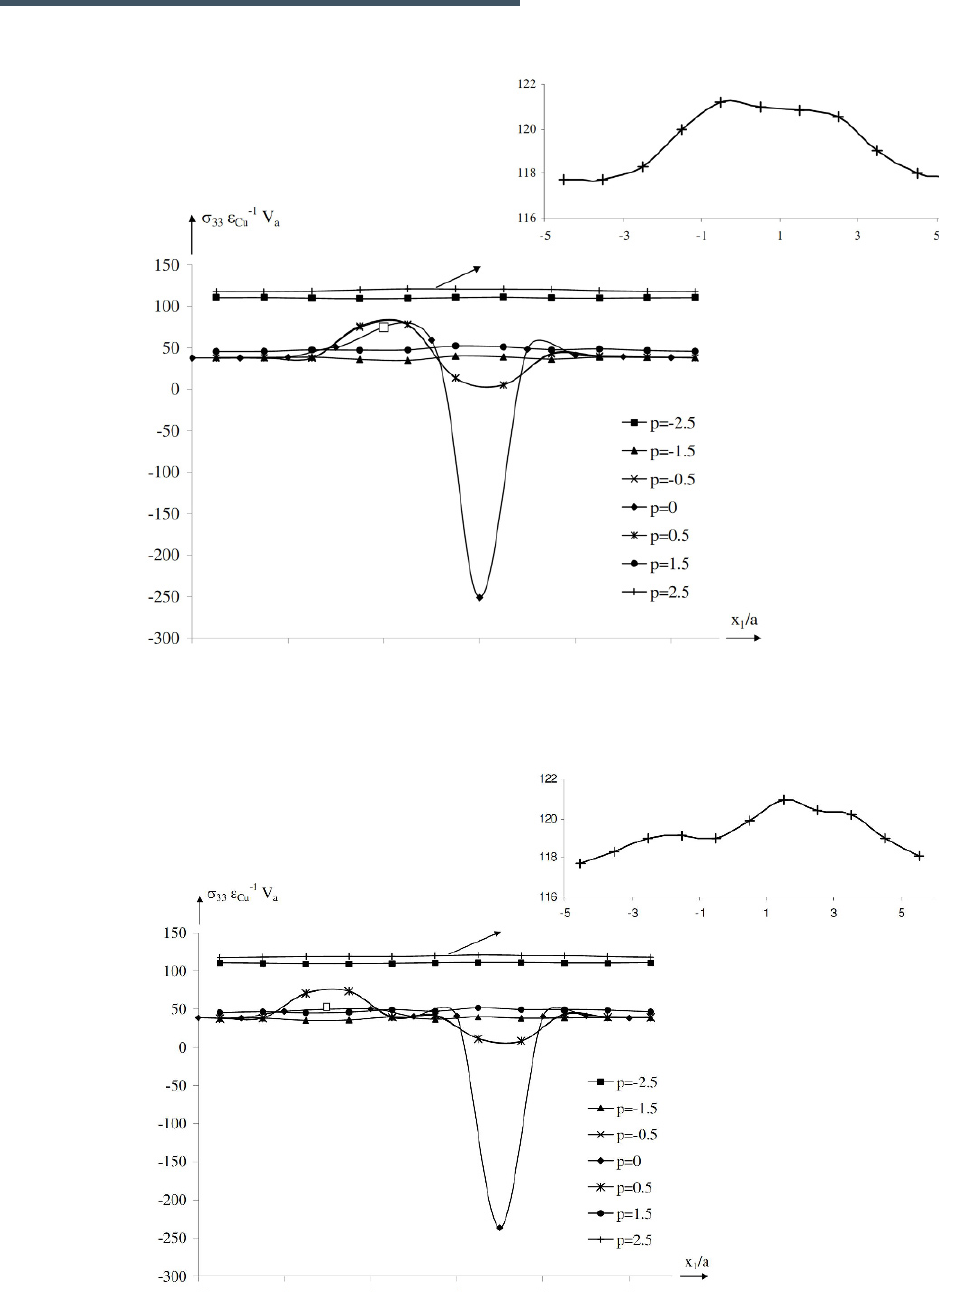
Figure 7. The normalized stress distribution along the atomic layers within the (010) plane containing a dopant-vacancy system for (a) L and (b) L = 4 a .